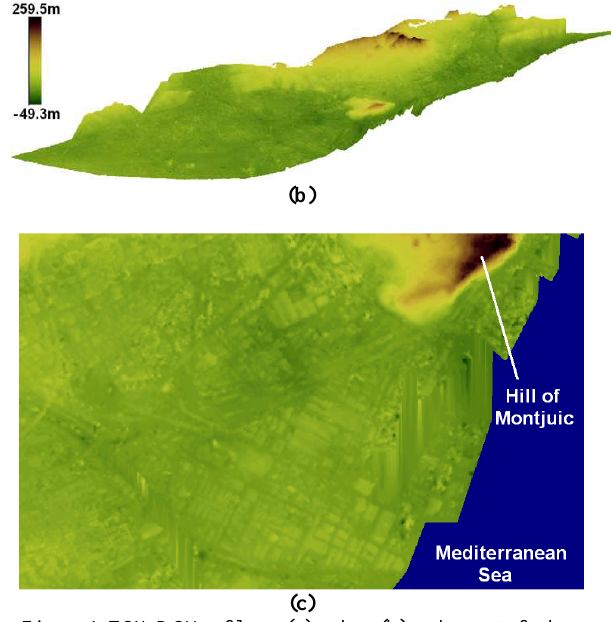
Figure 4. TSX DSM of large (a), urban (b) and a part of urban area (c)